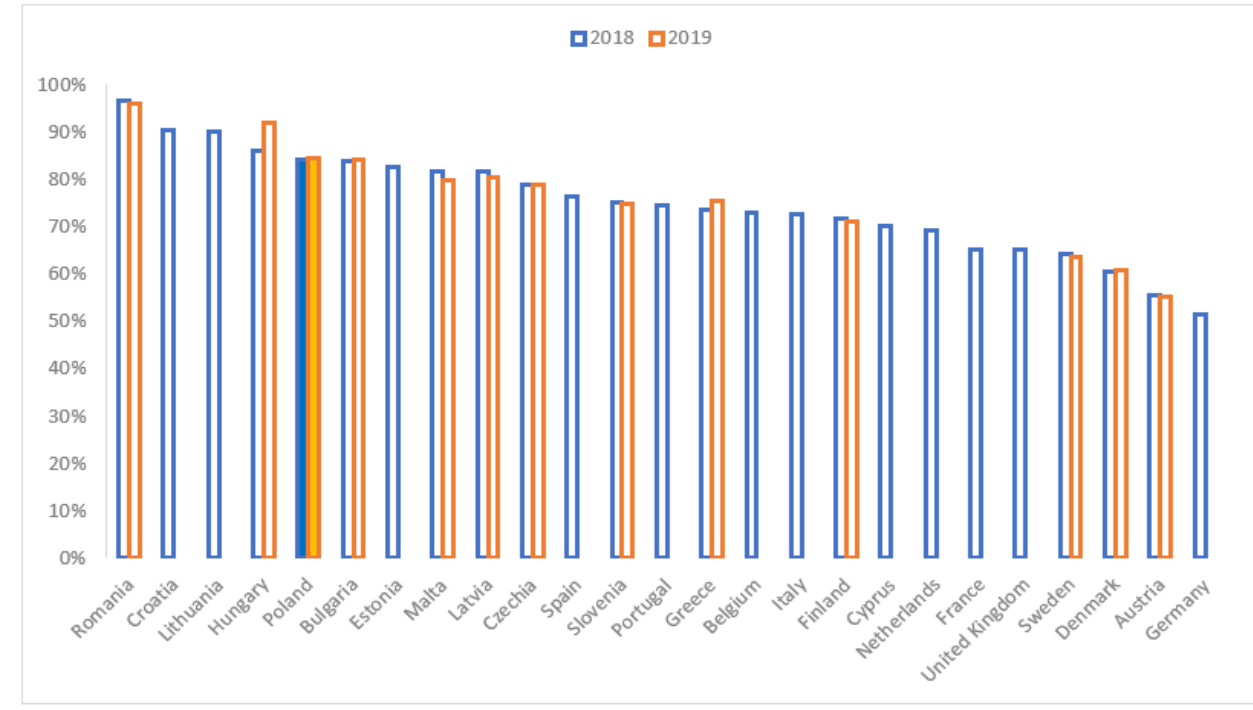
Figure 1. Home ownership rate in selected European countries 2018–2019. Source: own elaboration based on the data from Eurostat (July 2020).